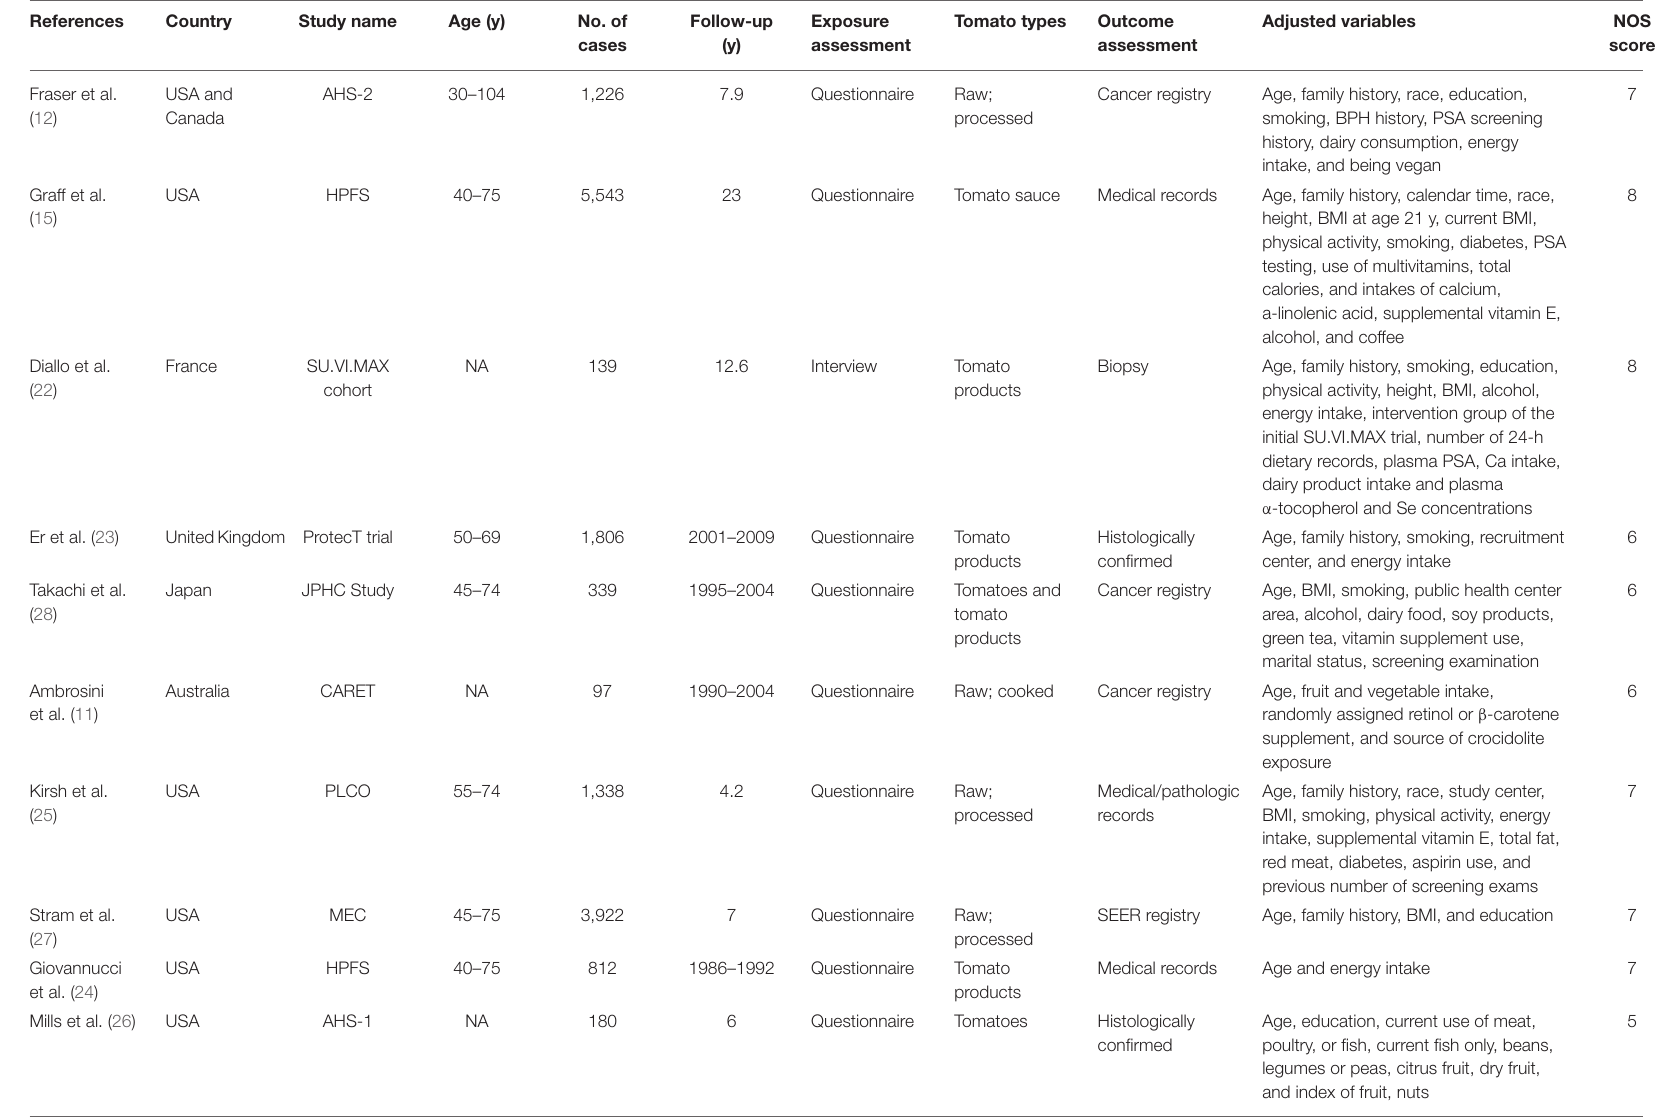
TABLE 1 | Main characteristics of the included